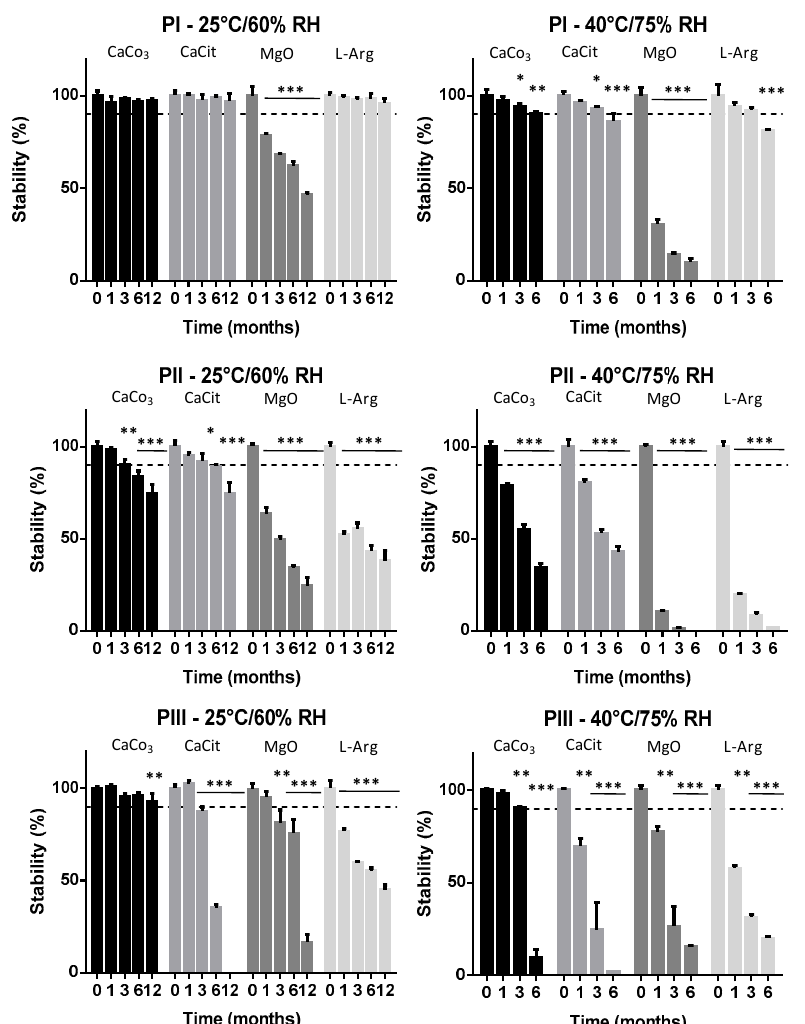
Figure 2. Stability of commercially available MK7 products, either from fermentation PI (Gnosis) and PIII (Sungen Bioscience) or from chemical synthesis PII (Kappa Biosciences), both in long term conditions (25 ◦ C/60% RH; left panel) and accelerated conditions (40 ◦ C/75% RH; right panel). At each experimental time, co-formulants are reported in sequence relative to different colors of bars: Formulation of MK7 with calcium citrate; calcium carbonate; arginine; and magnesium oxide. Data are reported as mean + SD. Experiments were conducted in triplicates. Significance of variation versus time zero values * p < 0.05; ** p < 0.01; *** p < 0.001.